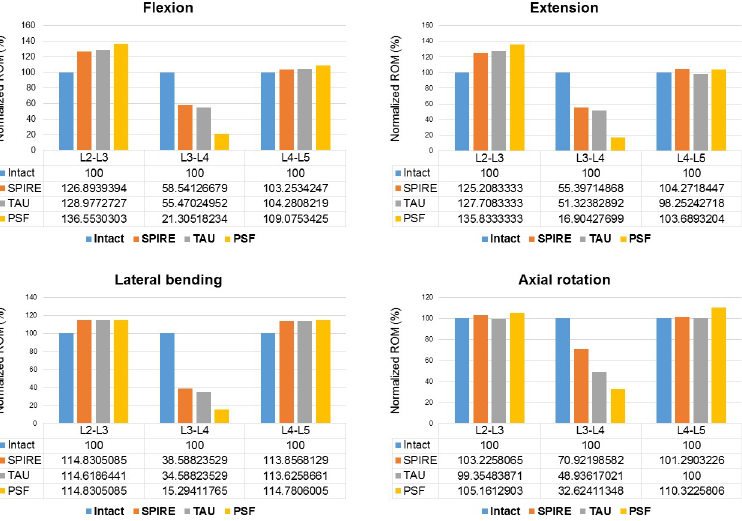
Fig 2. Range of motion for the intact and implanted lumbar models (Data were normalized with respect to the intact model as percentage values).